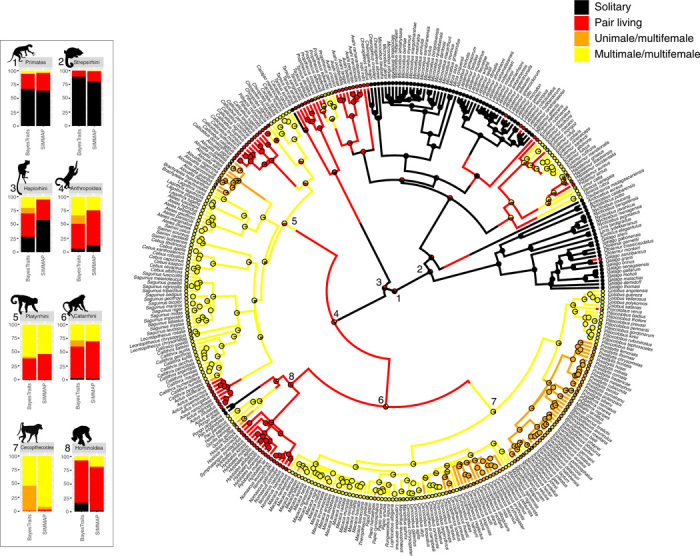
Primate phylogeny showing ancestral state reconstructions for sociality under the RJ-MCMC–derived model of evolution.Branches and tips are colored for solitary (black), pair living (red), unimale (orange), and multimale (yellow) using one tree randomly selected from the 10,000 trees in the stochastic mapping process. Pies at each node are derived from ancestral state reconstruction using the function ace (R package ape v.5.0). Ancestral state reconstruction using both stochastic mapping (SIMMAP/ace) and BayesTraits for eight main nodes (1: primate root; 2: Strepsirhini root; 3: Haplorhini root; 4: Anthropoidea root; 5: Platyrrhini root; 6: Catarrhini root; 7: Cercopithecoidea root; 8: Hominoidea root) are reported in the stacked bar graphs on the left.